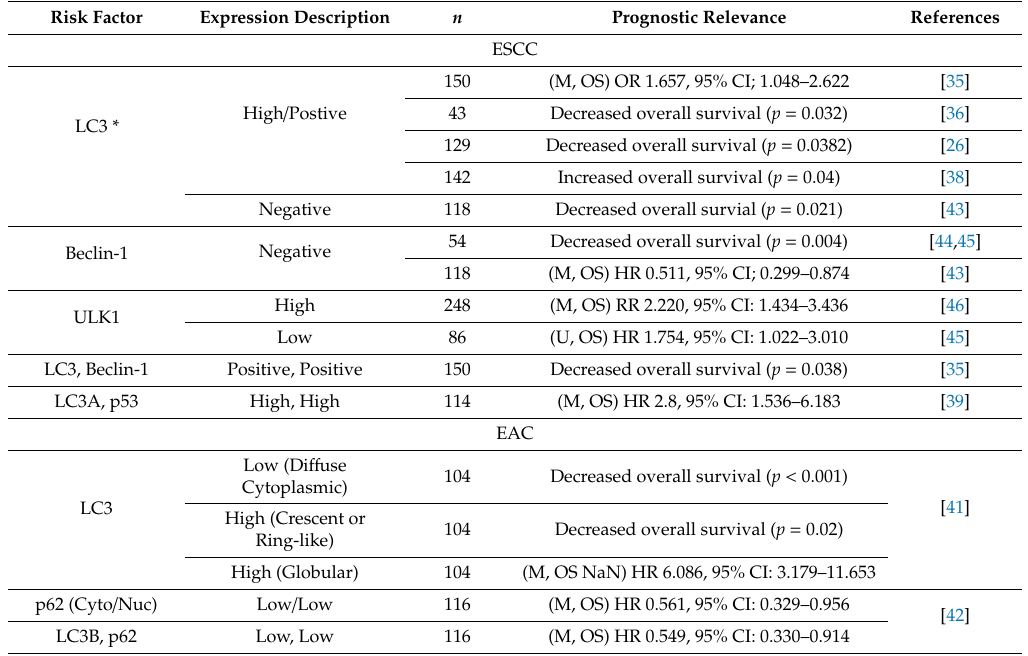
Table 1. Autophagy markers showing significant association with survival in esophageal cancer Risk Factor Expression Description n Prognostic